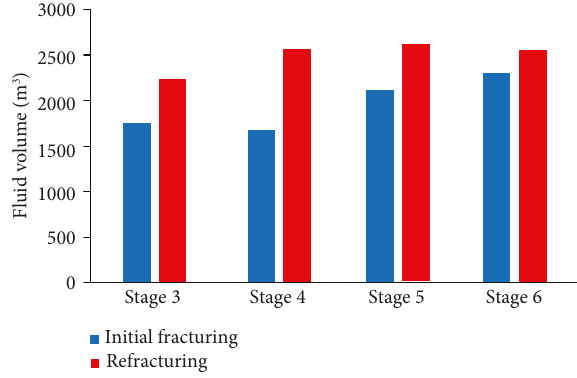
Figure 14: Comparison of the total fl uid volume of the initial fracturing job and refracturing